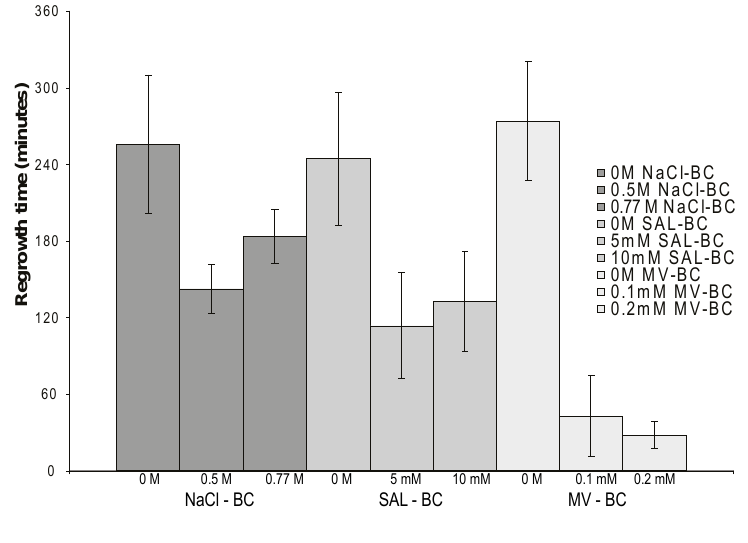
Figure 4. Regrowth time in BC (min) for cells pre-grown in osmotic and oxidative stress; NaCl (sodium chloride), SAL (salicylic acid), MV (methyl viologen). 0 M is the non pre-exposed